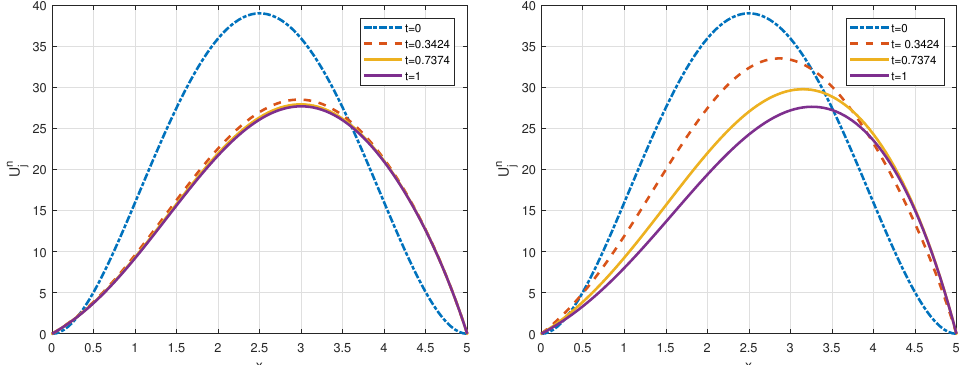
Figure 4. Numerical solutions of the FPDE (25) with N = J = 100 at different time steps. Left frame: α = 0.1. Right frame α = 0.9.